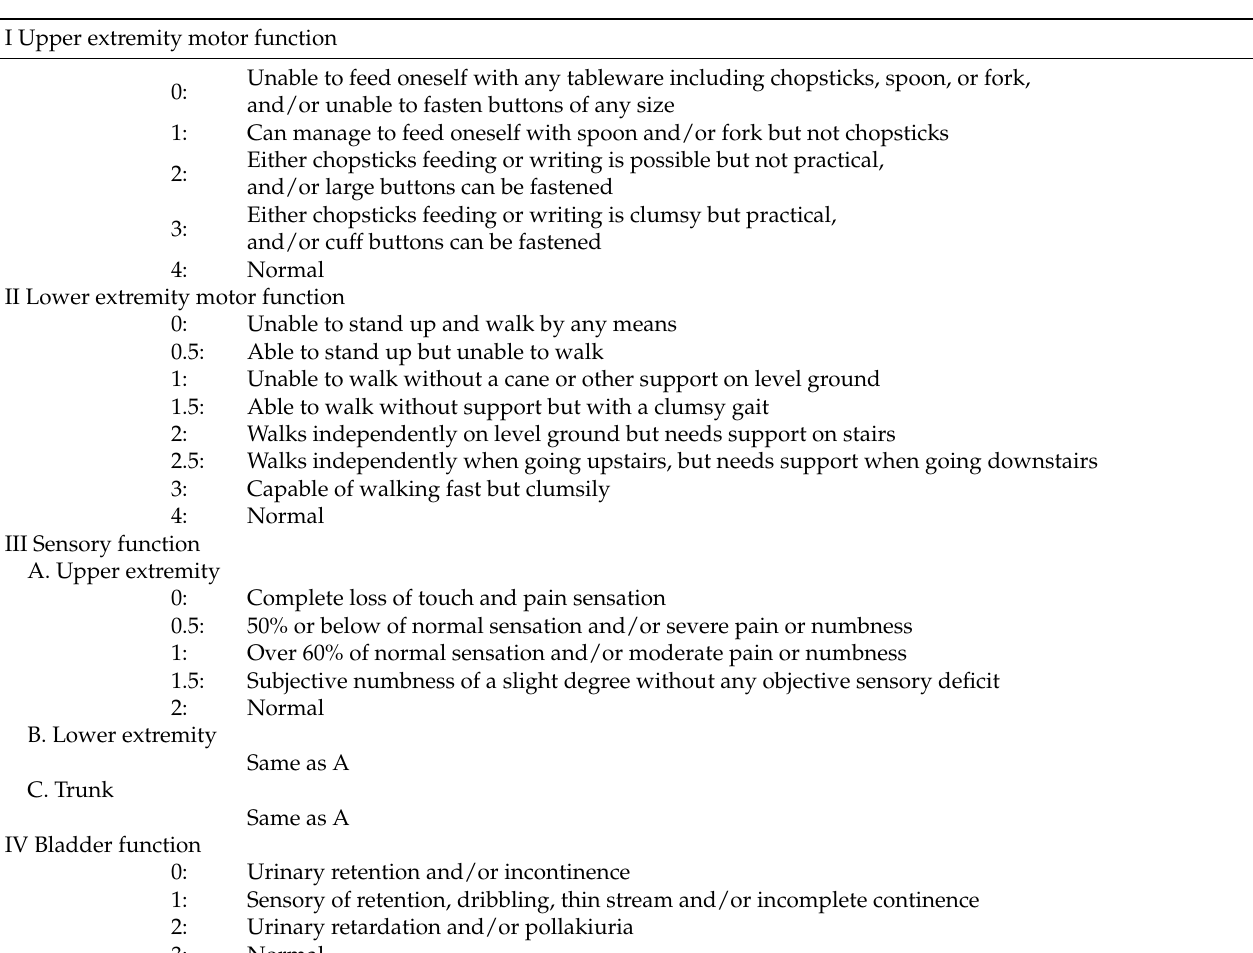
Table 1. Scoring system for cervical myelopathy (JOA